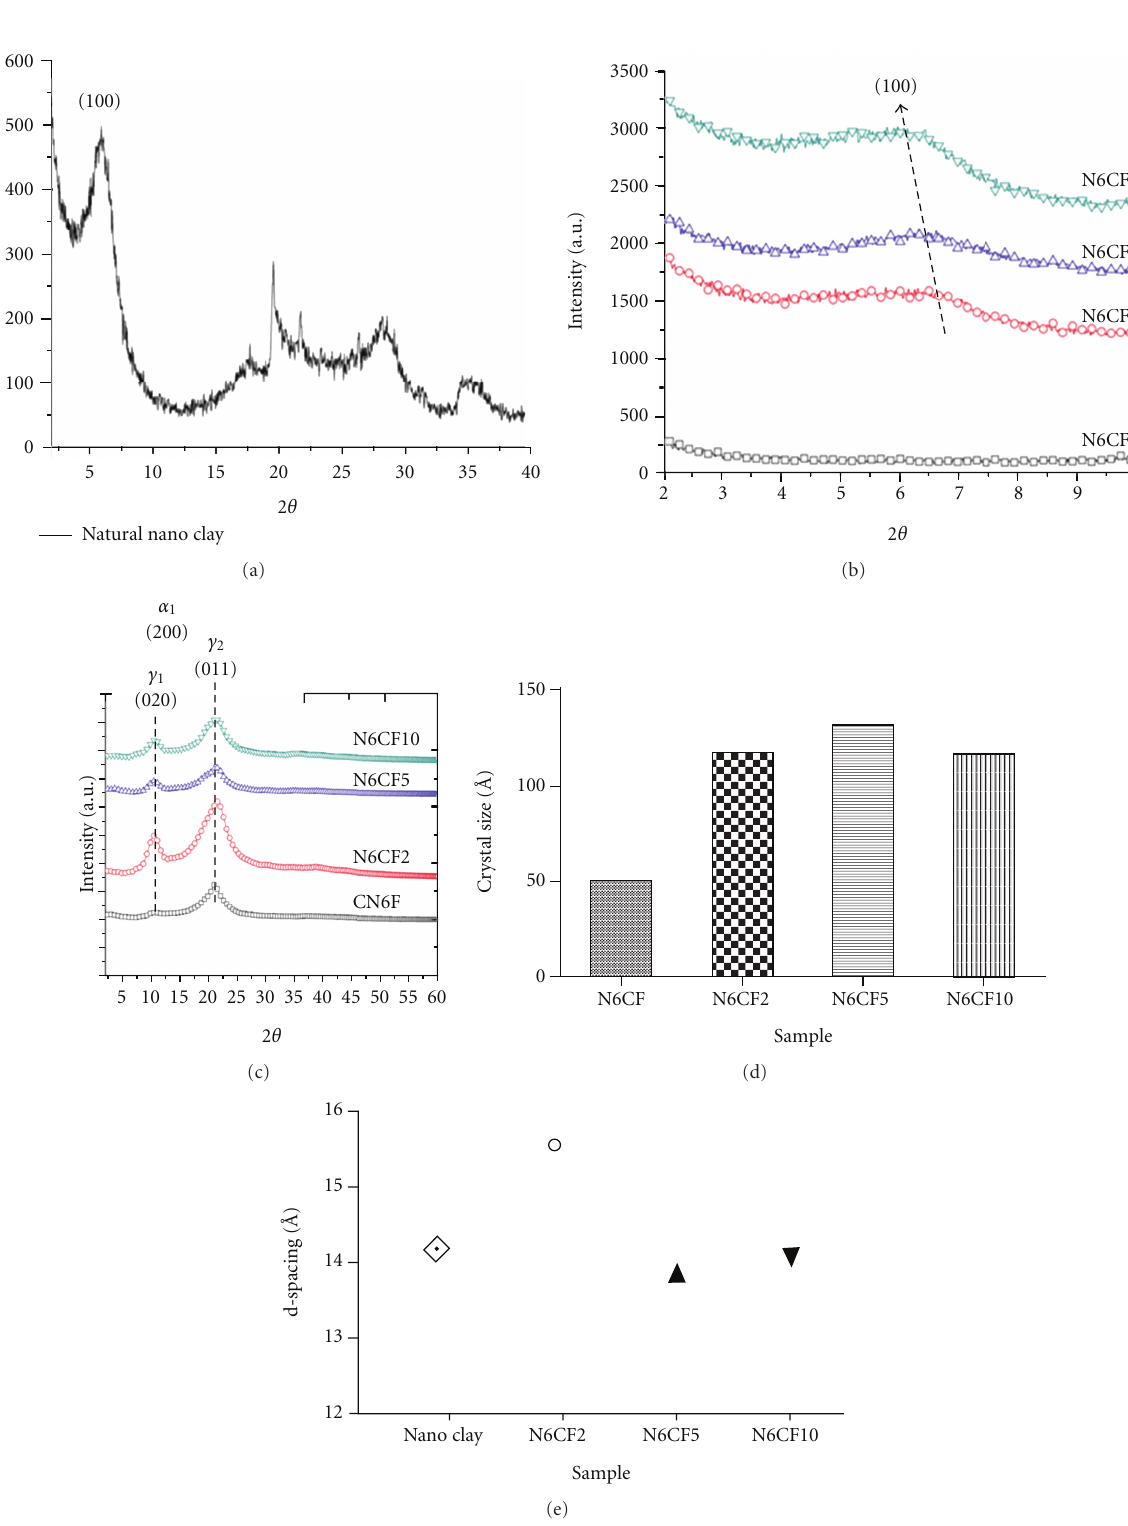
Figure 1: WAXD scans of (a) neat nanoclay (b) peak corresponding to (100) plane of neat nanoclay, (c) film samples, (d) crystal size, (e) results of d -spacing of from (100) peak position. (Color figure can be viewed in the online